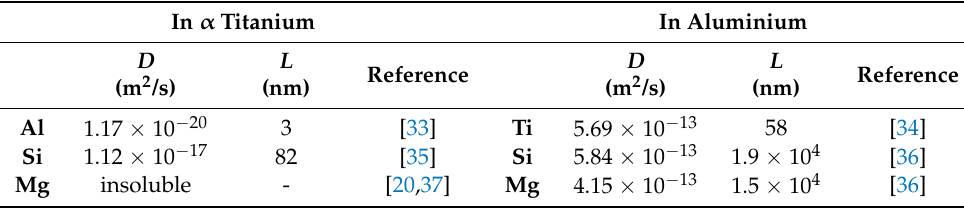
Table 3. Diffusion properties of the elements at the sintering temperature. Diffusion coefficients D √ Dt ) are shown for the diffusion of Al and Si into Ti and for Ti and V into and diffusion lengths ( L = Al. The values were calculated for T = 560 ◦ C, t = 600 s (isothermal part of the sintering program). In α Titanium In Aluminium D